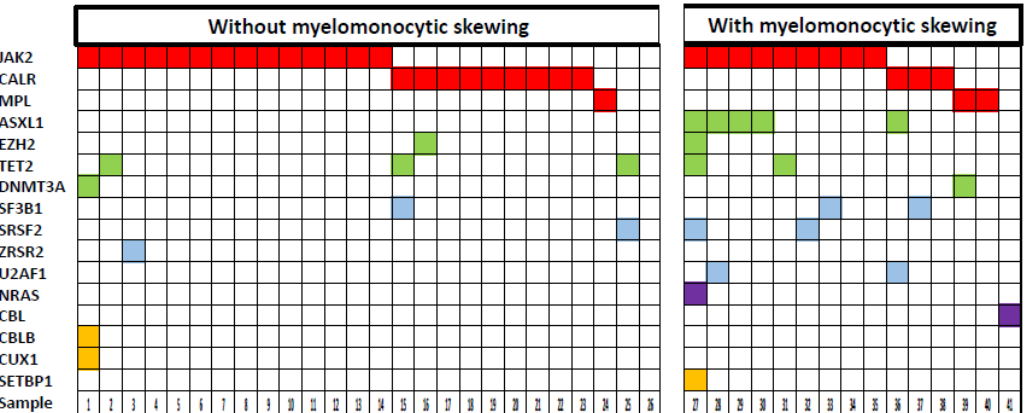
Figure 4. Comprehensive mutation status of genes in myelofibrosis patients with and without myelomonocytic skewing. Each column corresponds to one patient. Colored squares indicate mutated, white squares indicate wild-type genes. The colors of mutant genes indicate the most affected functional categories. Red, green, blue, purple and yellow represent the driver mutations, epigenetic regulators, spliceosome, RAS-pathway and other components, respectively.